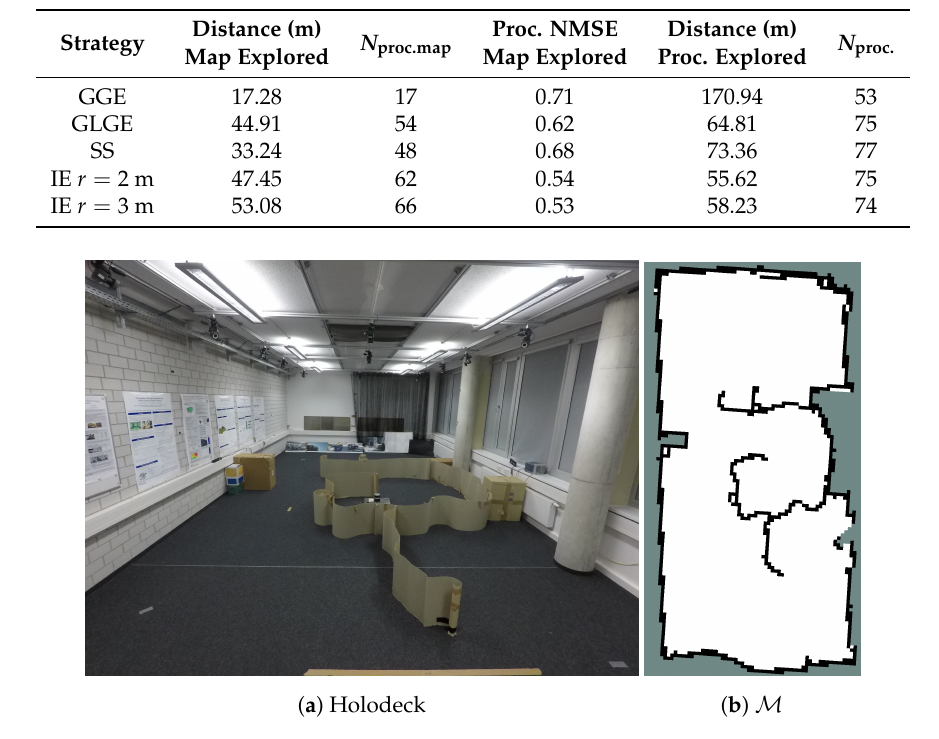
Figure 14. E1: Experiment with holonomic robotic platform.